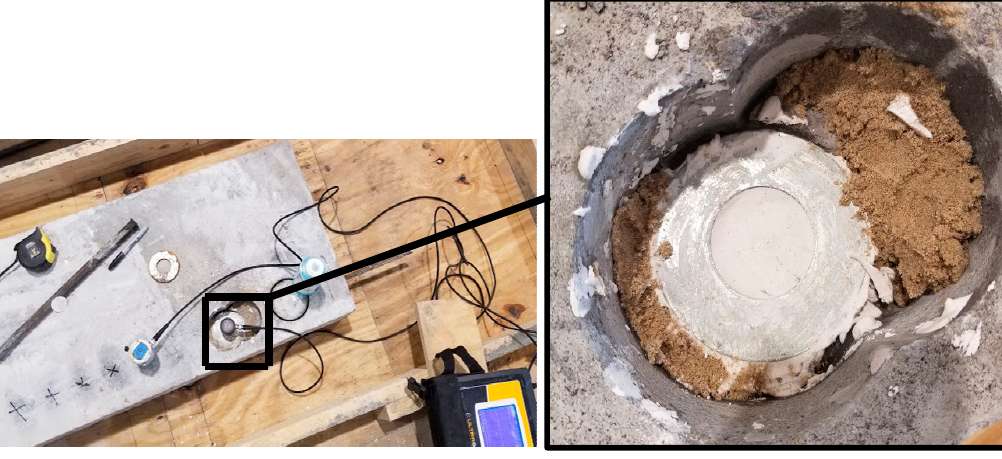
Figure 18. Hydrocal gypsum cement placed on top of the rebar to improve the coupling condition.